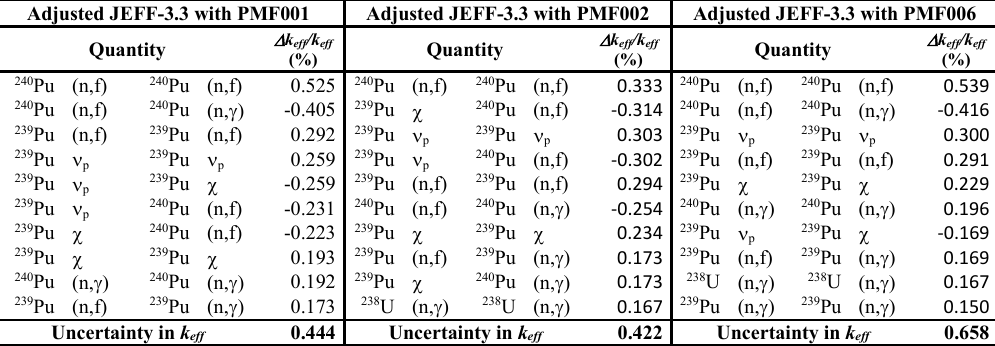
Table 4. UQ for MYRRHA using adjusted covariance